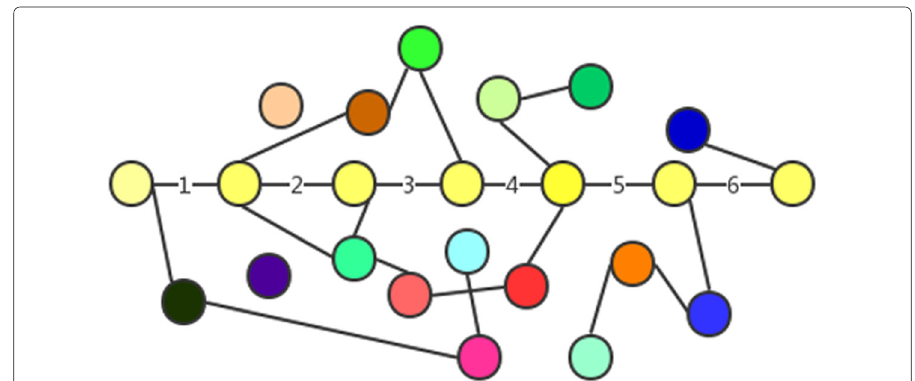
Fig. 2 Social relations between